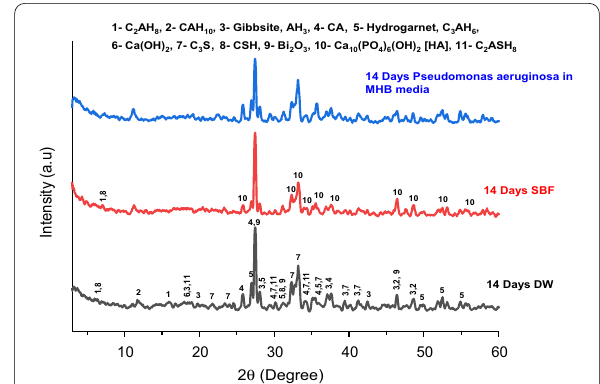
Fig. 8 X-ray diffraction patterns of 14-day sample cured in distilled water (DW) simulated body fluid (SBF) and Pseudomonas aeruginosa in Mueller Hinton Broth (MHB media)